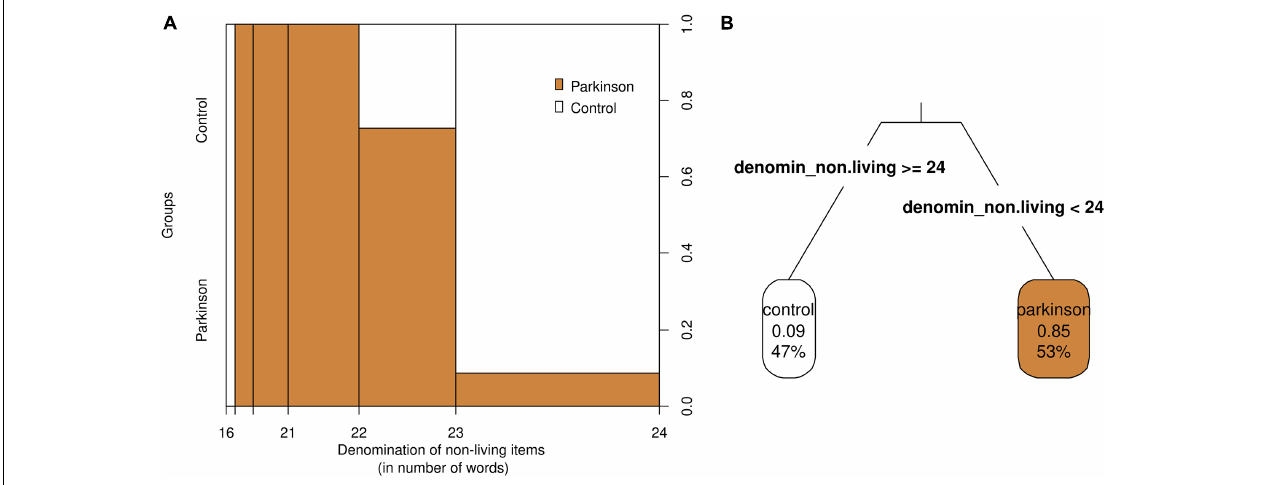
FIGURE 1 | Spinogram (A) and classification tree (B) of the model group ∼ dnlt . (A) The widths of the bins in the x -axis in the spinogram represent the frequencies (number of participants that obtained a score) within each bin. For example, there were more observations between 23 and 24 denominations than between 16 and 21 denominations. Colors represent groups, white being for controls (always on top) and orange being for PD patients (always below). The right y-axis represents the proportion of subjects that belonged to each group in each of the bins. (B) The classification tree shows the likelihood of being classified as control or PD depending on a cut-off score of 24 in the denomination of non-living things